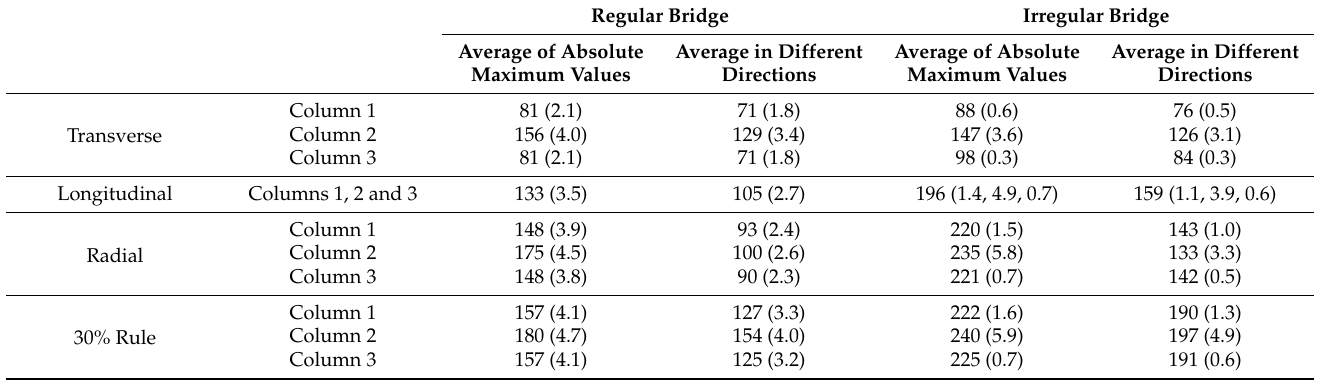
Table 4. Summary of the mean displacements (mm) of columns using 3D analysis for the regular and irregular bridges by applying the records at their critical angle (i.e., maximum possible seismic demands). Mean ductility demands given in brackets.